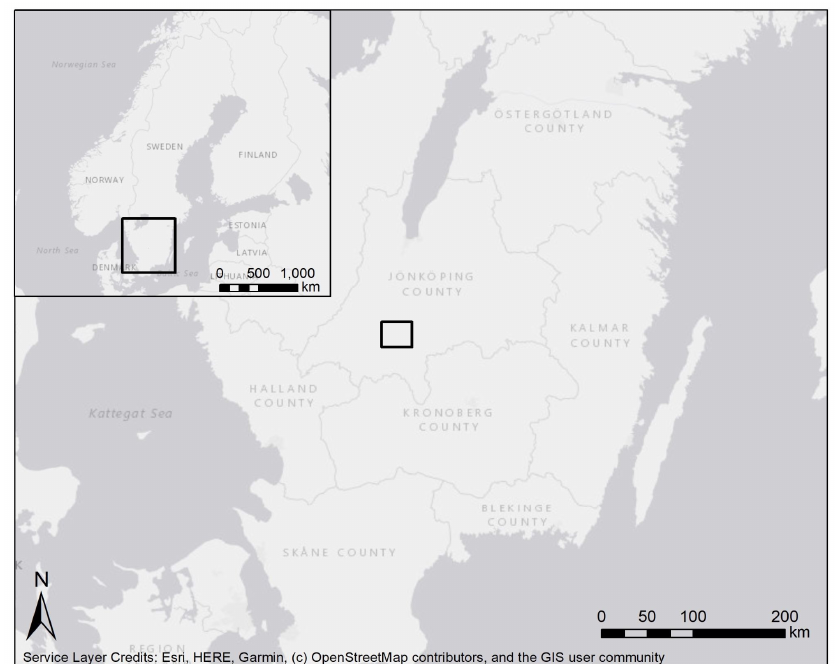
Figure 3. Map of the study region. The black box shows the geographic extent of the LiDAR analyzed in this